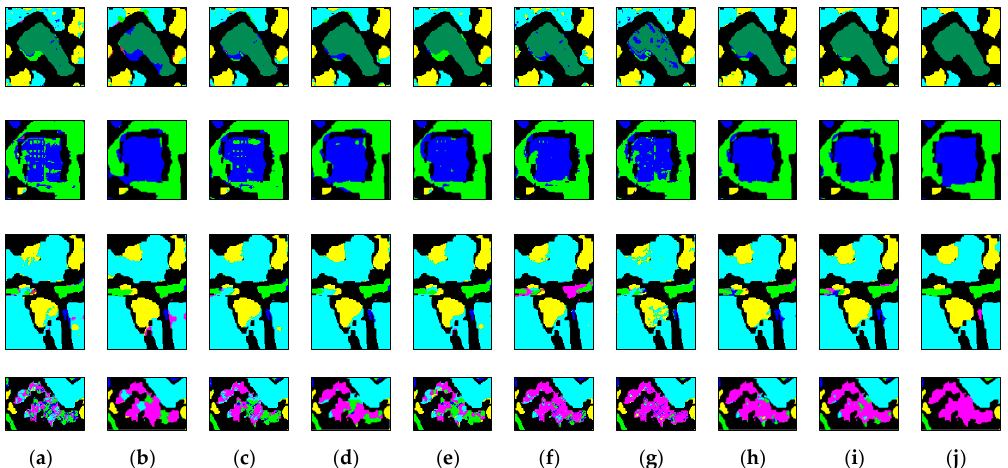
Figure 17. Comparison of local classification results obtained by: ( a ) original bands; ( b ) SLIC Raw (when S = 15); ( c ) PGF (with r = 4); ( d ) SGF (with r = 5); ( e ) GF Prob (with r = 6); ( f ) MPGF (with r = [1,25]); ( g ) EMPs (with r = [1,25]); ( h ) the proposed MSGF (with r = [1,25]); ( i ) the proposed FS-MSGF (with r = [1,25] and F = 30); ( j ) the reference map, where four rows correspond to four sub-regions highlighted in Figure 15 (Zh2).